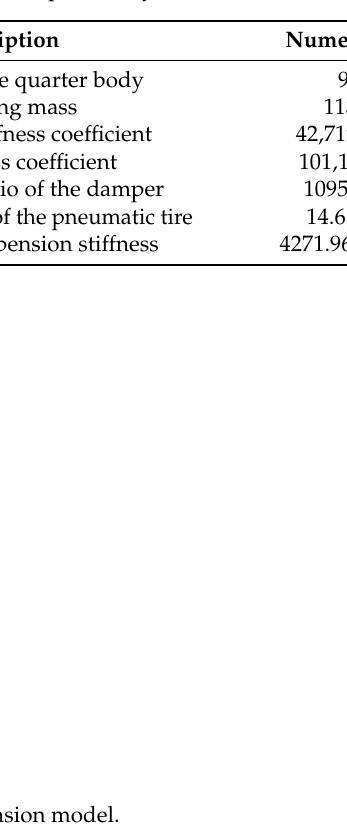
Table 1. The parameters of the quarter-vehicle suspension system.